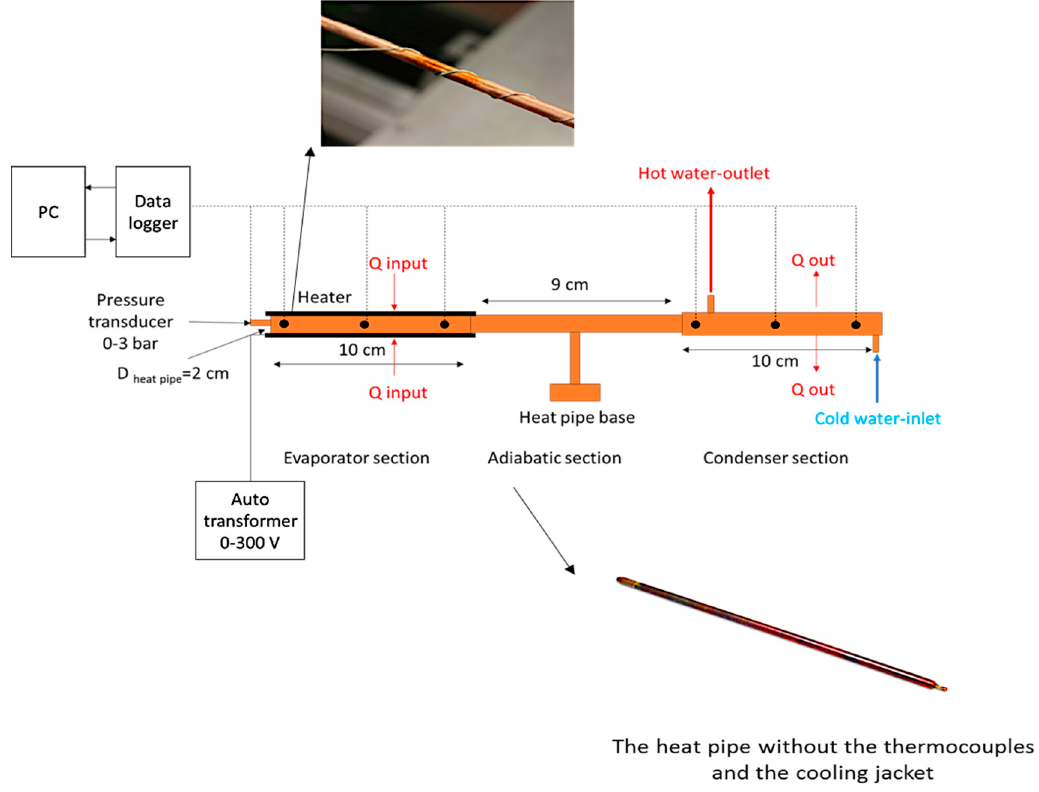
Figure 1. A schematic illustration of the studied apparatus.